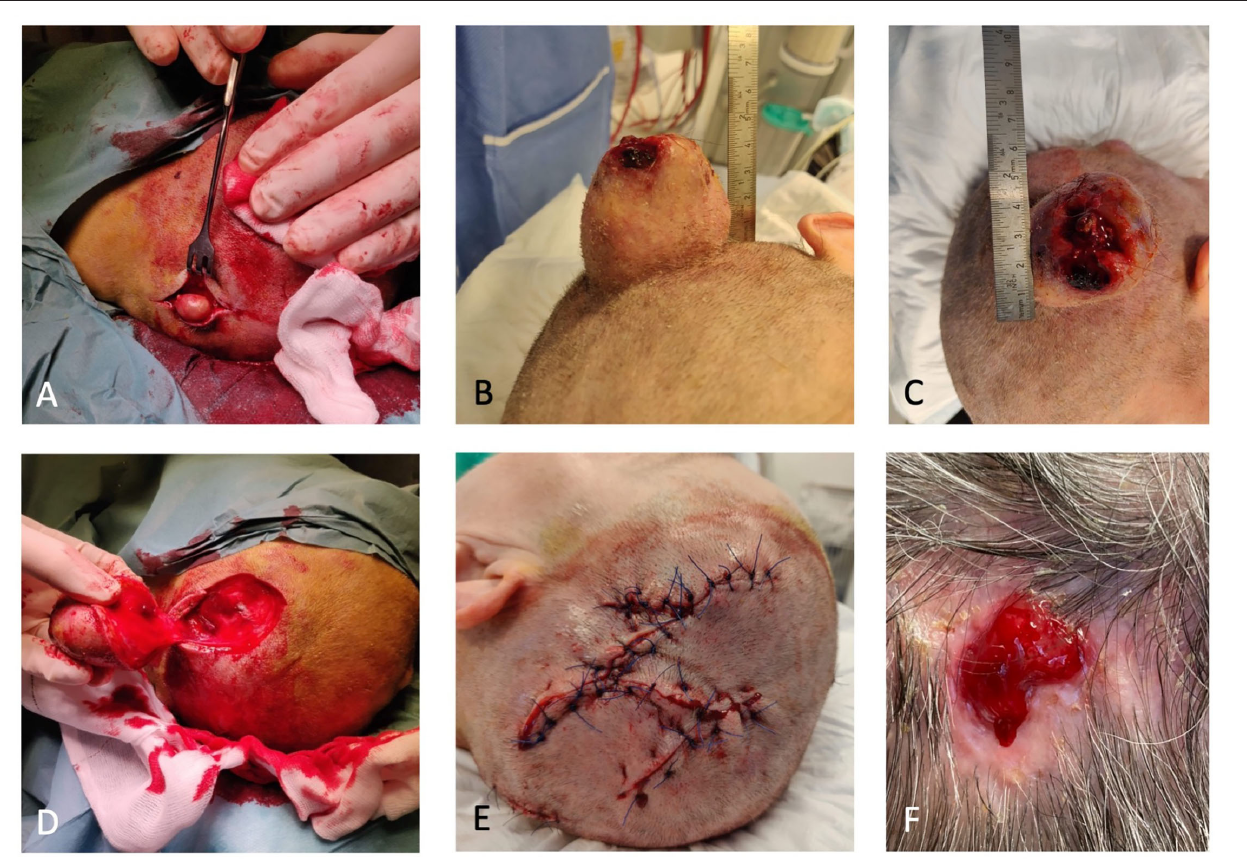
FIGURE 2 | (A) One of the two smaller trichilemmal cysts (TCs). (B) Proliferating trichilemmal cyst (PTC) peroperative. (C) PTC with an ulcerating center. (D) Defect after removal of PTC. (E) Closure with local fasciomusculocutaneous flaps. (F) Small wound 6 months after primary closure.